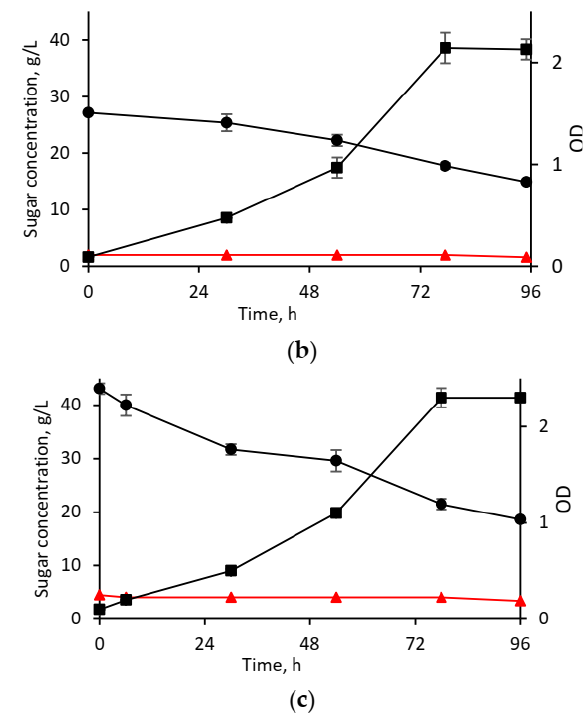
Figure 4. Sugar consumption and cell growth during cultivation of B. atrophaeus BU4 in cellulosic hydrolysates containing 15 ( a ), 30 ( b ), or 45 ( c ) g/L glucose. Glucose, circles; xylose, triangles; OD,